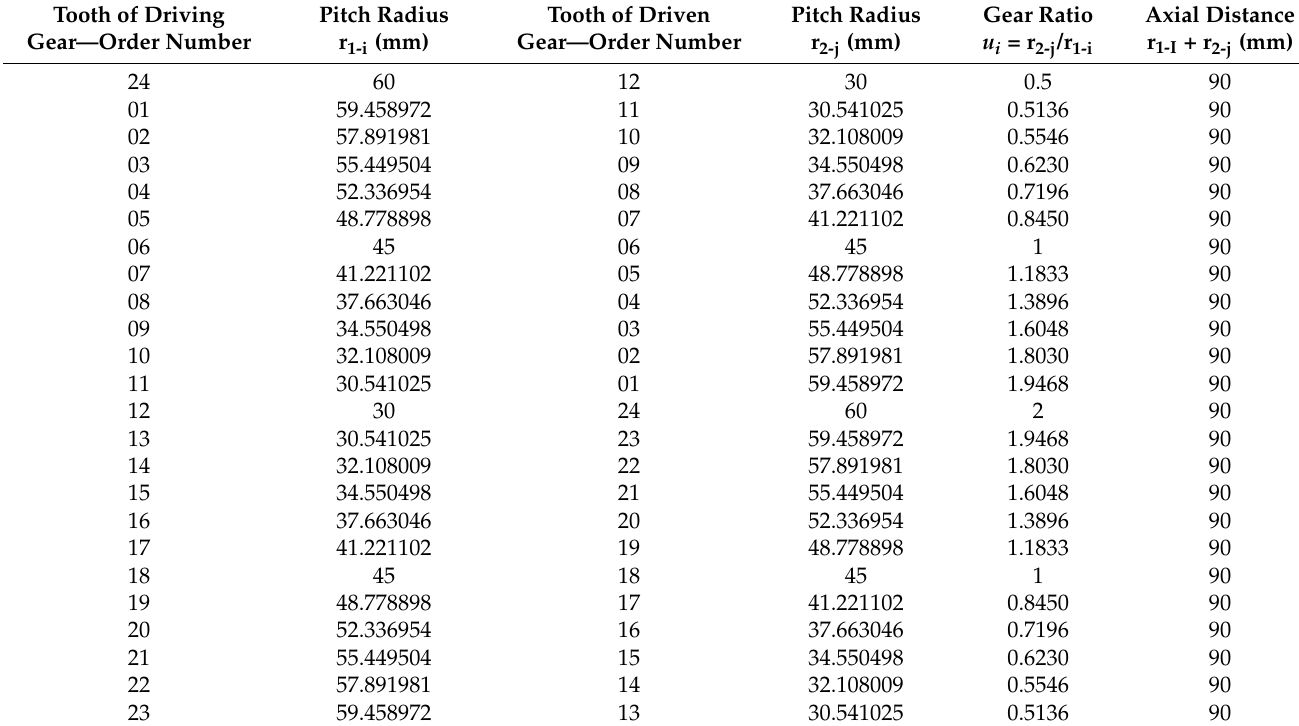
Figure 5. Pitch ellipses of the eccentrically placed intermeshing gears. Table 1. Pitch radii and changing gear ratio.